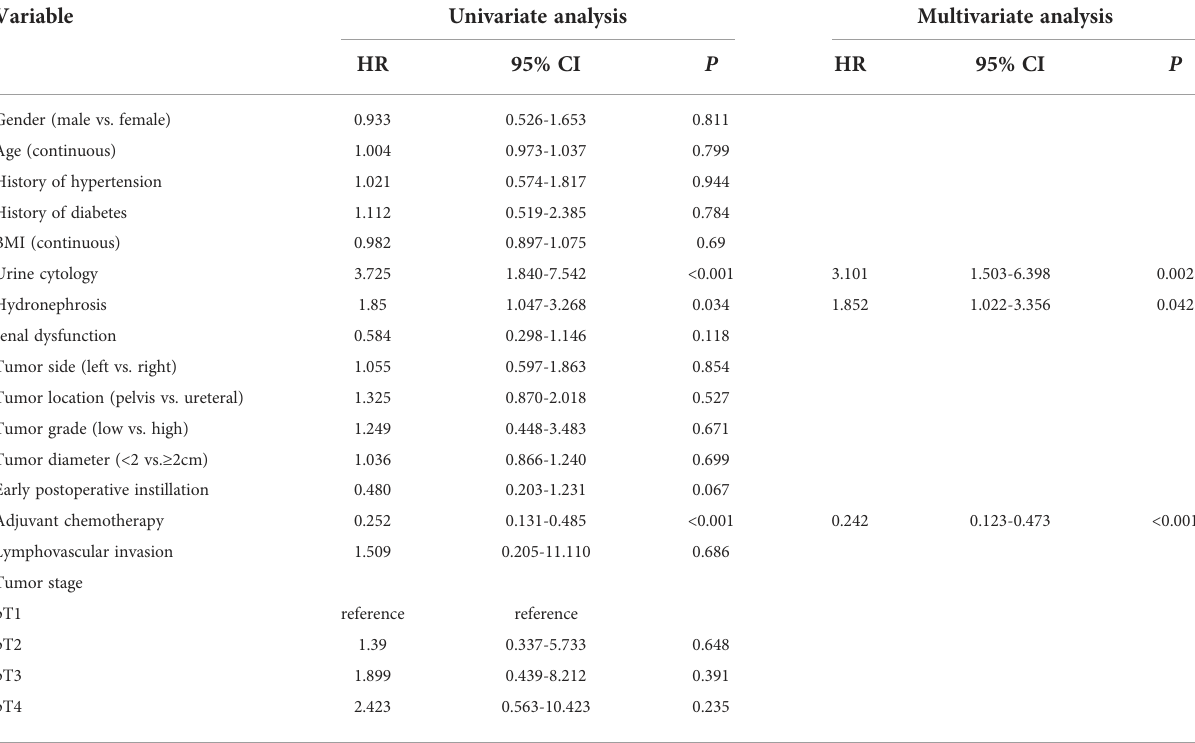
TABLE 3 Univariate and multivariate Cox regression analyses predicting intravesical recurrence in 139 patients treated with radical nephroureterectomy for primary upper urinary tract urothelial carcinoma.